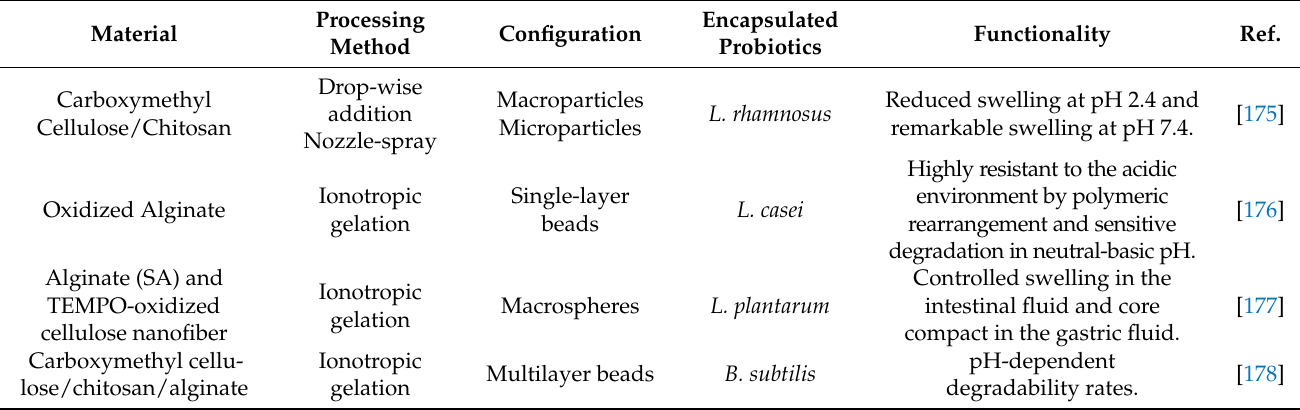
Table 5. Relevant pH-responsive matrices for improving probiotics